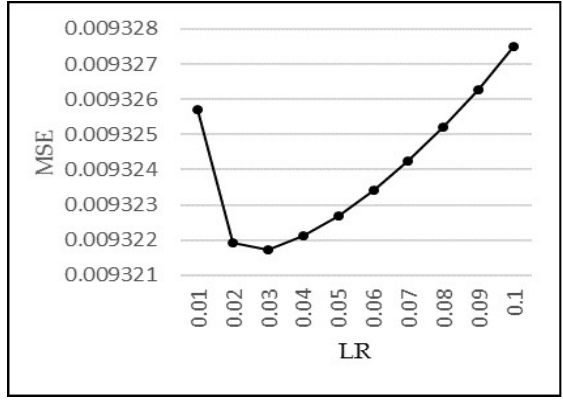
Figure 11. MSE vs. Learning